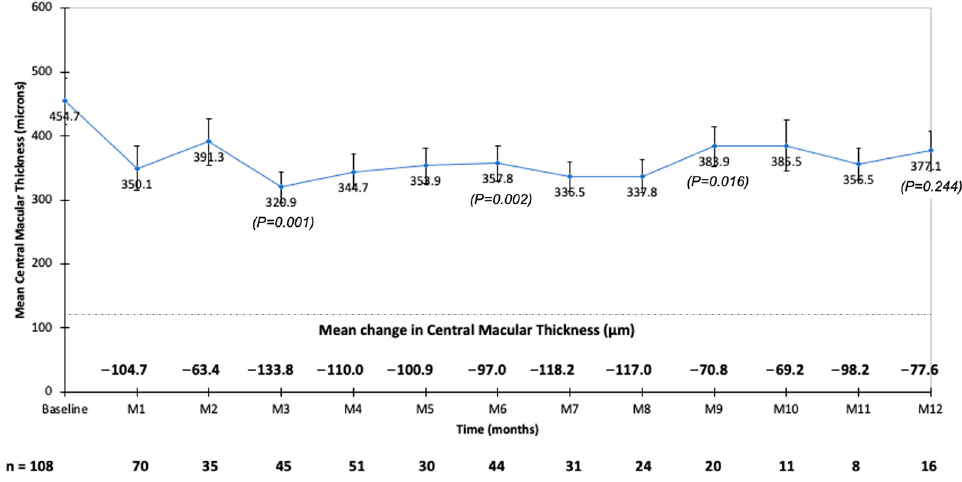
Figure 2. Mean central macular thickness (CMT) and mean change in CMT during the follow-up